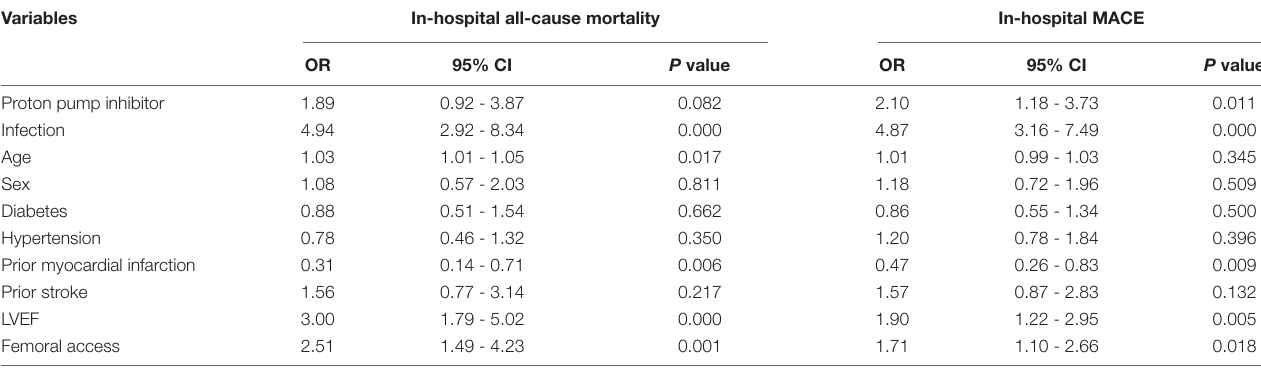
TABLE 3 | Multivariable analysis of in-hospital all-cause mortality and MACE.